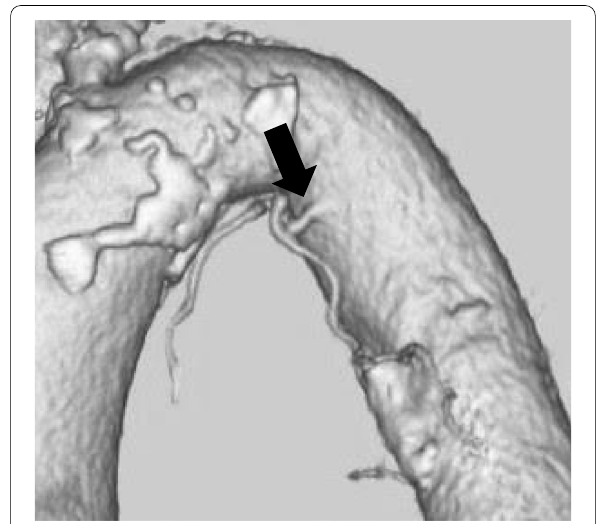
Fig. 1 Computed tomography angiography of bronchial arteries. The arrow indicates the common trunk of bronchial arteries which arose from the thoracic